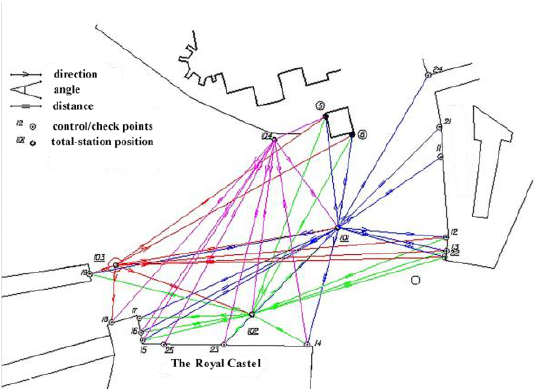
Figure 3. Example of a geodetic network (first-order) used for data registration